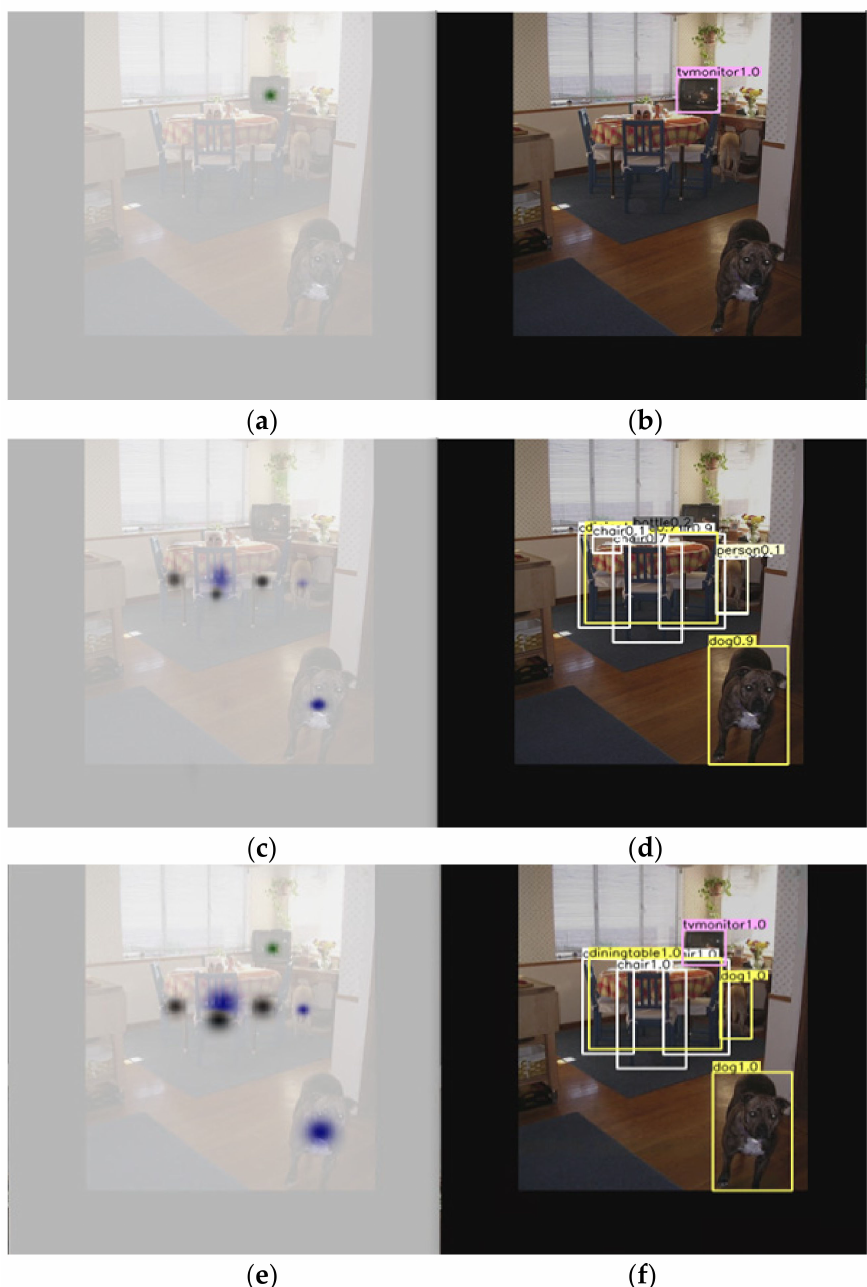
Figure 4. Example of results according to the input image in the 19 + 1 scenario: ( a ) Example of synthesis of heatmap and input image of GT; ( b ) bounding box of object in input image of GT; ( c ) example of synthesis of t-model prediction heatmap and input image of t-model; ( d ) prediction of t-model bounding box of object in input image; ( e ) example of heatmap image synthesis of GT’; ( f ) visualization of GT’ bounding